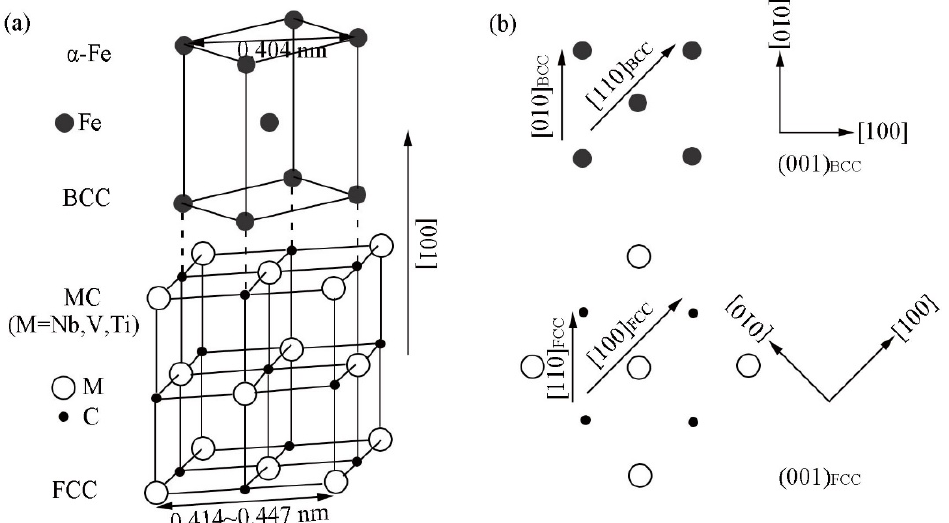
Figure 2. ( a ) Three-dimensional schematic diagram of BN OR; ( b ) The schematic diagram of atom distribution in (100) MC //(100) α of BN OR.